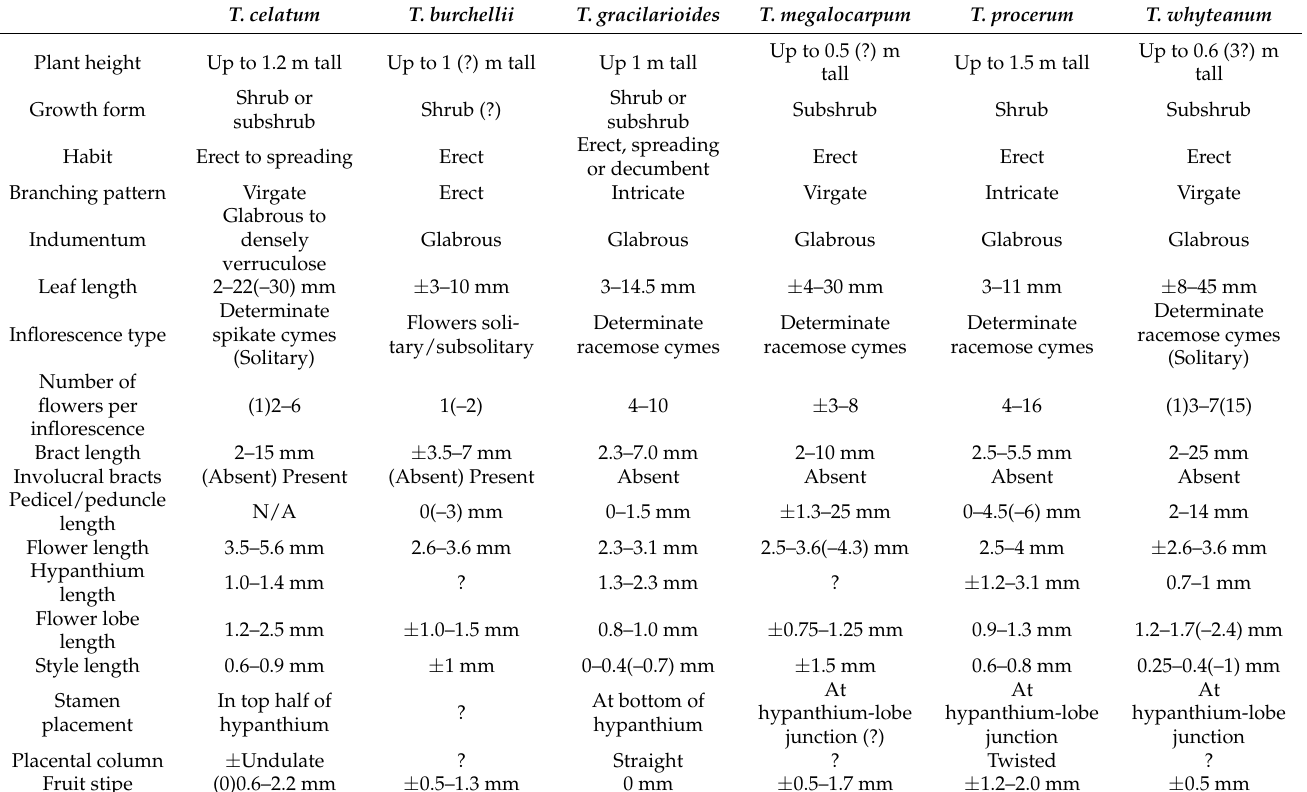
Table 1. A comparison of the main diagnostic characters to distinguish among Thesium celatum and five morphologically similar species, T. burchellii , T. gracilarioides , T. megalocarpum , T. procerum and T. whyteanum . Missing data are indicated with “?” and uncertain data with